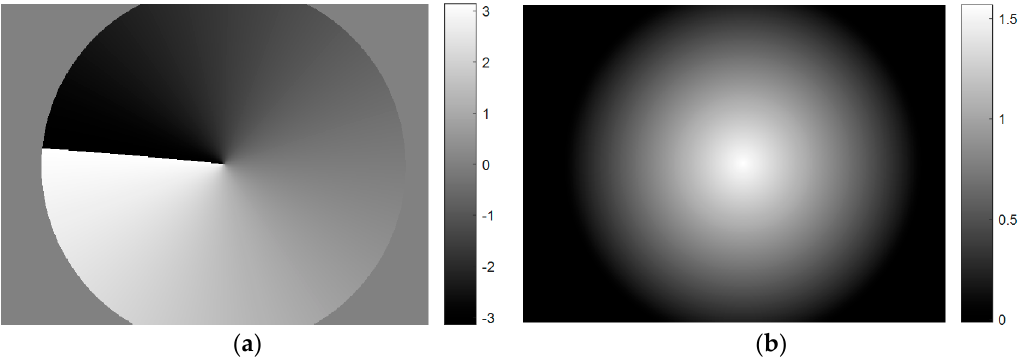
Figure 2. The resulting calibration of the fisheye camera, for each image pixel ( a ) the azimuthal angle θ and ( b ) the elevation angle φ is provided.